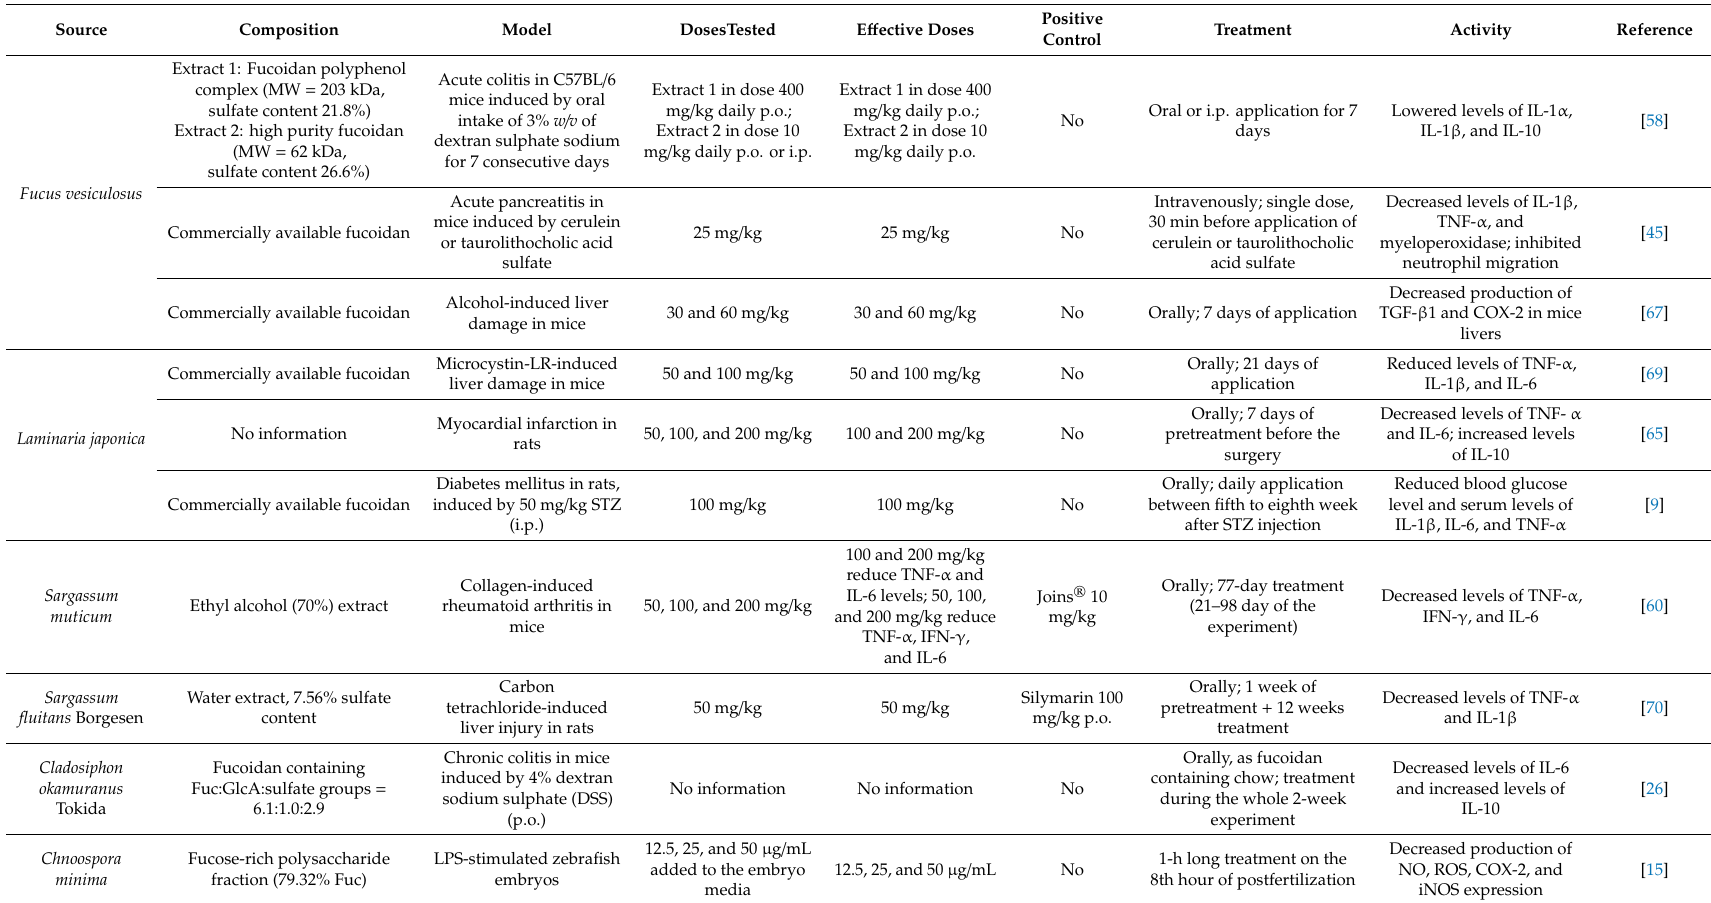
Table 2. In vivo anti-inflammatory activity of